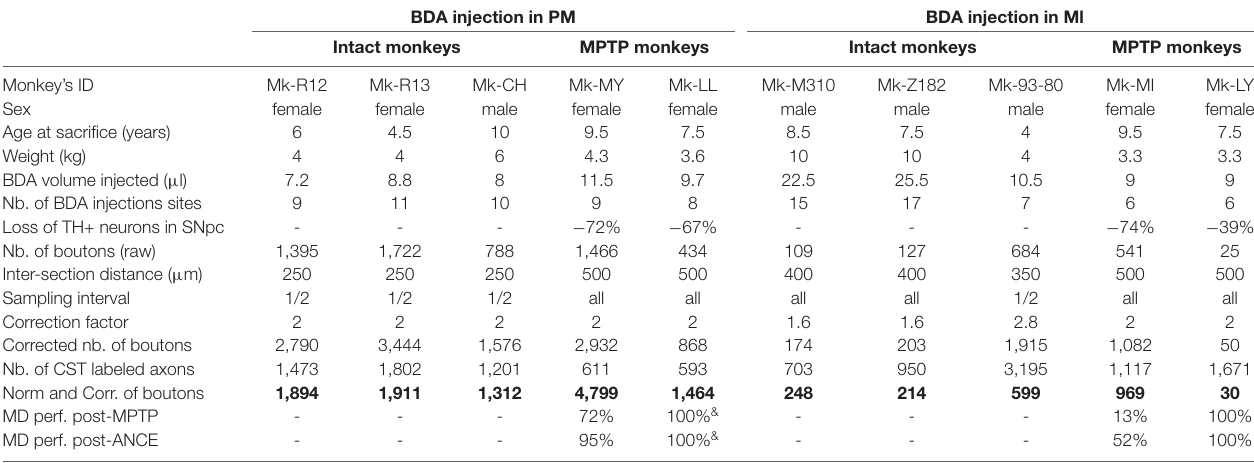
TABLE 1 | All monkeys were adult Macaca fascicularis